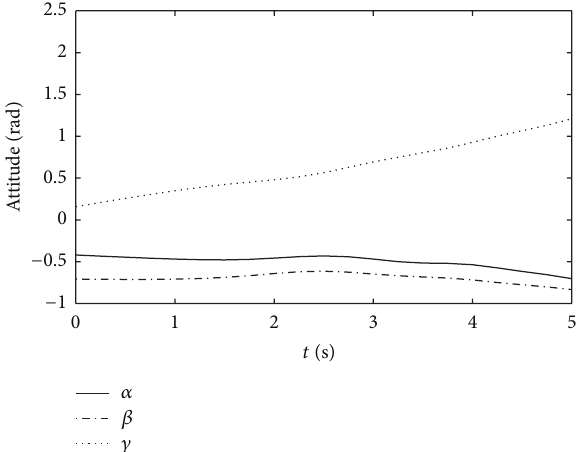
Figure 13: Trajectory of robot before obstacle avoidance trajectory planning.